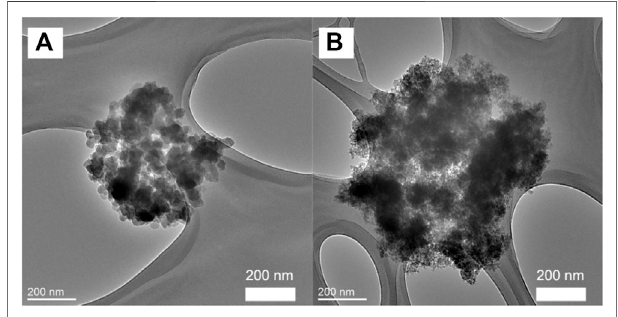
FIGURE 4 | TEM images of amorphous aluminosilicate samples prepared at 60 ° C for 6 h, 6h-W (A) and 6h-A (B) .